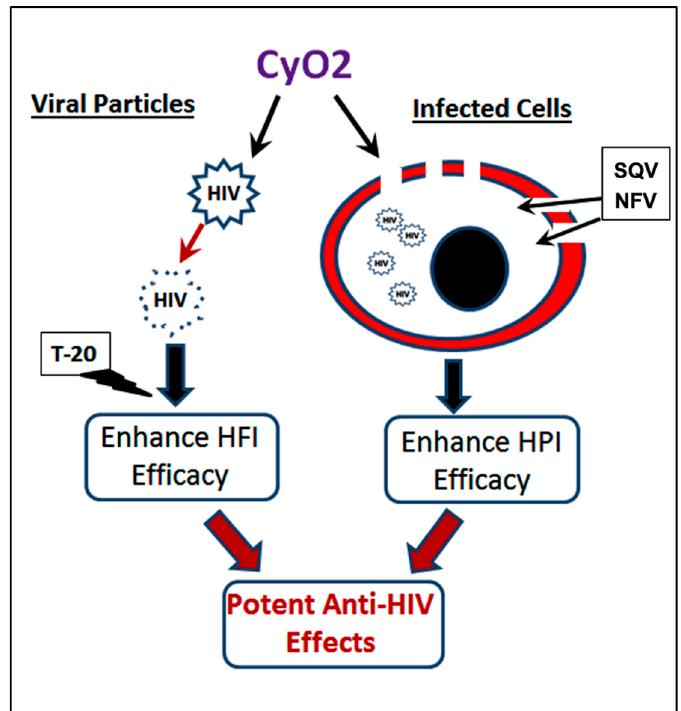
Figure 8. CyO2 targets both viral particles and HIV-1-infected cells. Membrane-targeting ability of CyO2 causes pore-formation in infected cells, which enhances the uptake of HIV-1 protease inhibitors, e.g., SQV and NFV. Furthermore, the ability of CyO2 to target the envelopes of viral particles suppresses their infectivity, which enables CyO2 to enhance the efficacy of an HIV-1 fusion inhibitor drug, T-20. Thus, this two-pronged effect of non-hemolytic doses of CyO2 may be a novel approach to augment the efficacy of multiple anti-HIV agents.